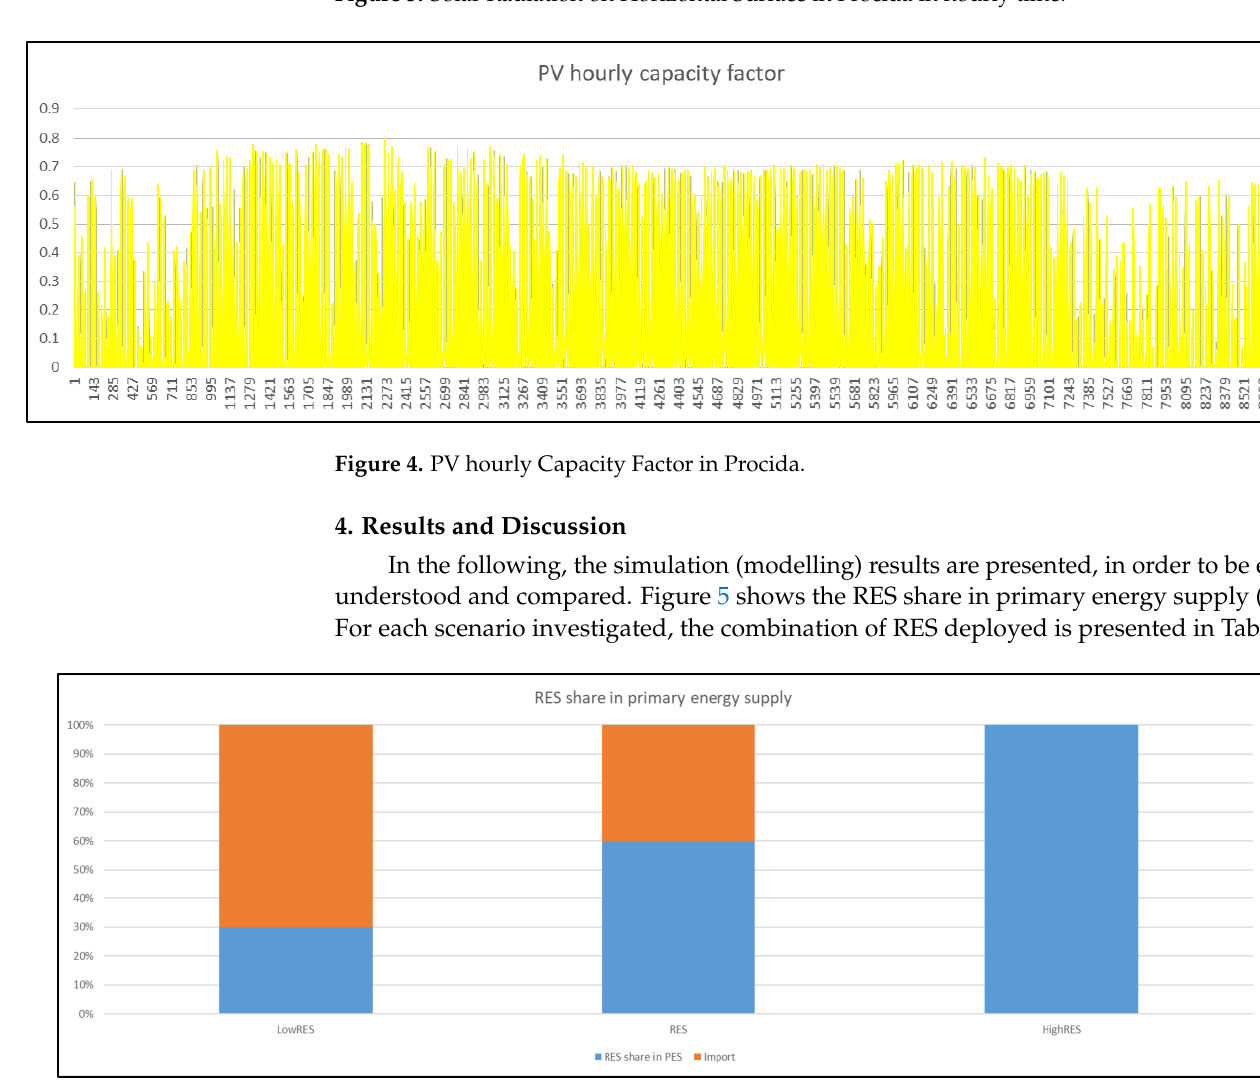
Figure 3. Solar Radiation on Horizontal Surface in Procida in hourly time.